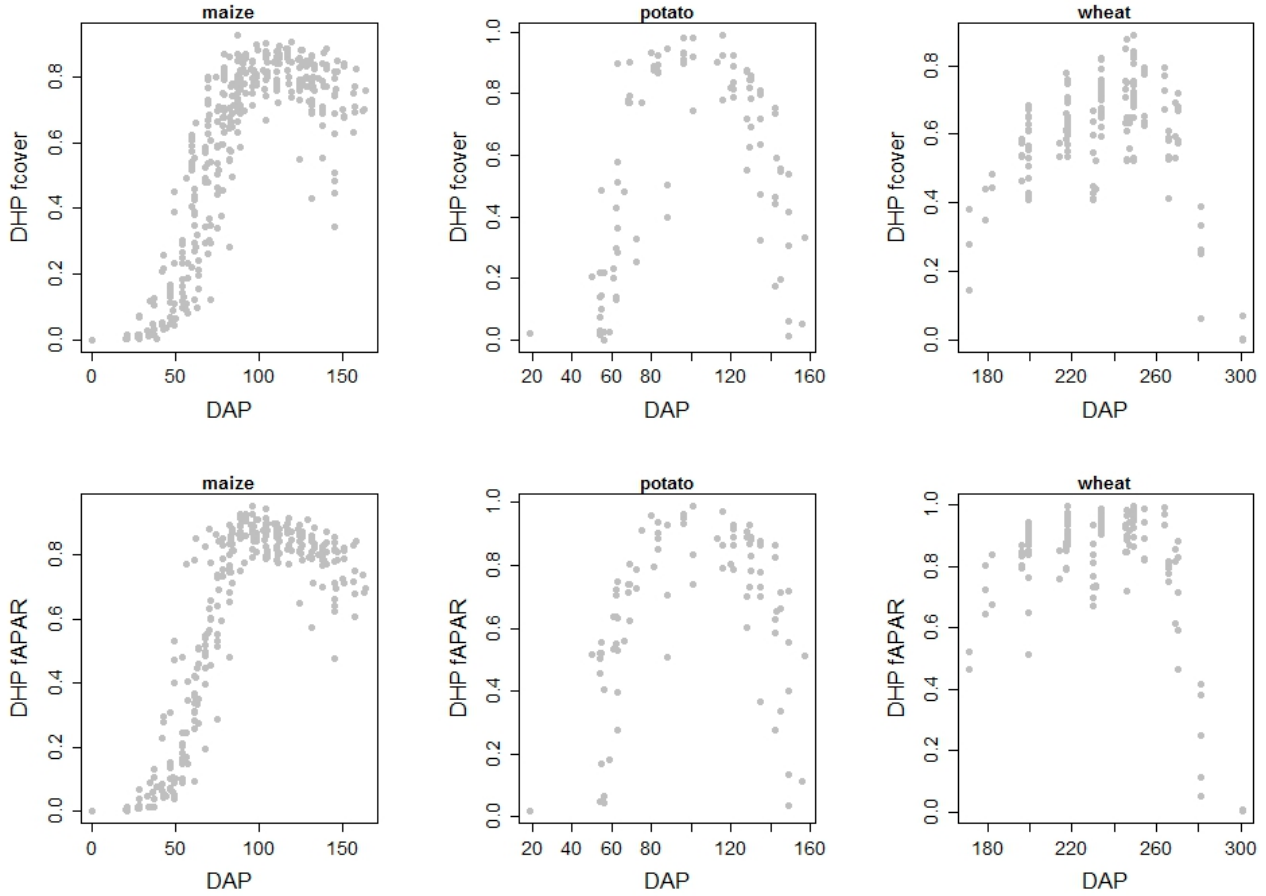
Figure 7. DHP-derived fCover and fAPAR versus days after planting/sowing (DAP) for maize, winter wheat, and potato for the period 2015–2017.